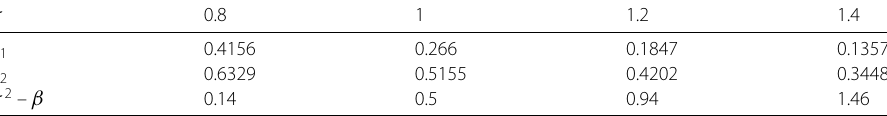
Table 2 The values with σ = 0.8,1,1.2,1.4